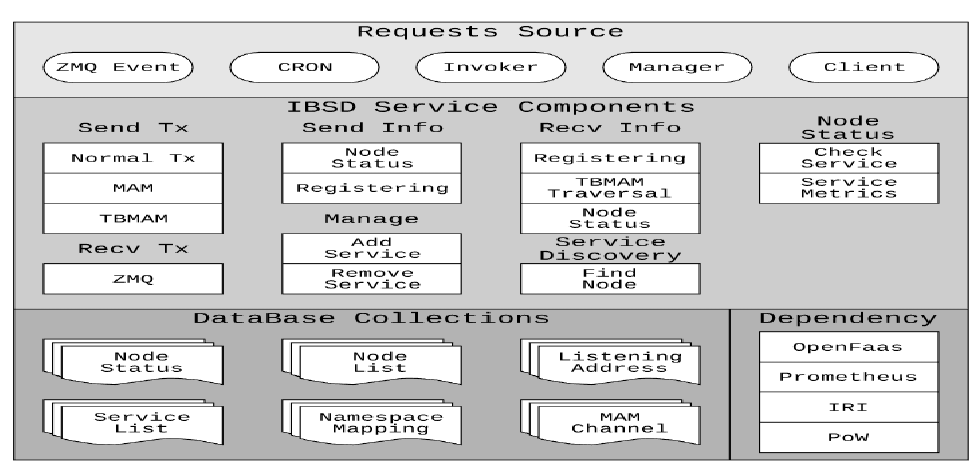
Figure 8. IBSD node composition .